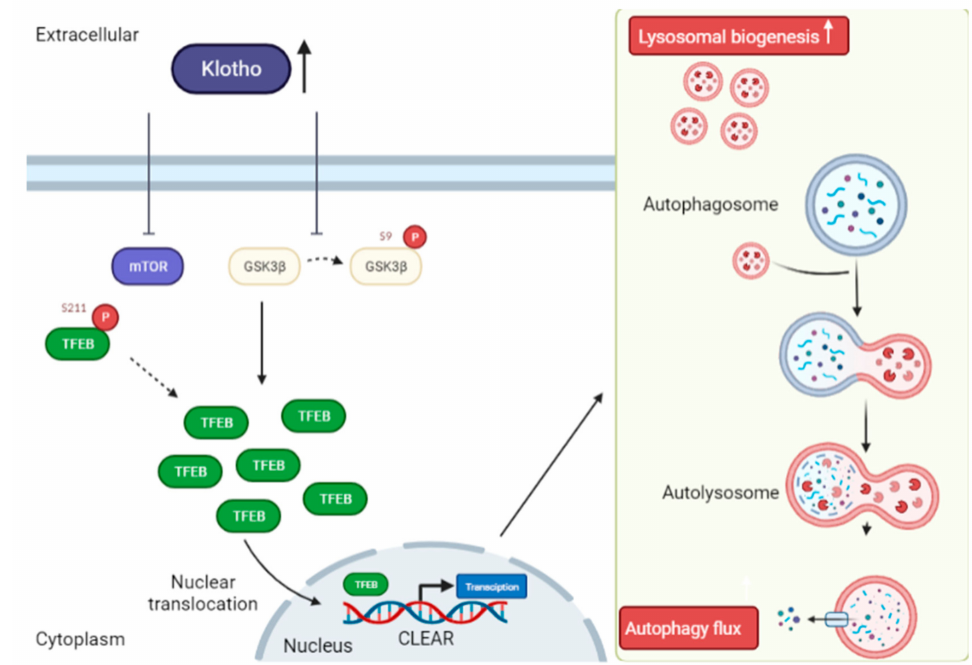
Figure 5. Mechanism of Klotho activity in autophagy induction through TFEB nuclear translocation. Soluble Klotho (sKlotho) or recombinant mouse Klotho (rKlotho) inhibits mTOR (S211) activity, thereby preventing TFEB phosphorylation resulting in nuclear translocation and activation of the transcription factor EB (TFEB). sKlotho or rKlotho also represses glycogen synthase kinase 3 β (GSK3 β ) (S9) phosphorylation to trigger TFEB nuclear translocation. Improved TFEB-mediated lysosomal gene transcription by sKlotho increases lysosomal biogenesis and eventually enhances autophagy